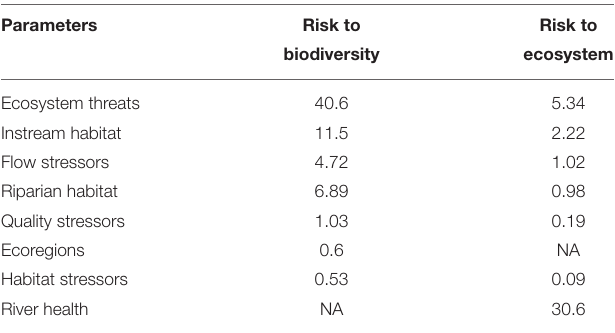
TABLE 1 | Sensitivity analysis for endpoints, showing the percent of calculated entropy for each endpoint attributed to input